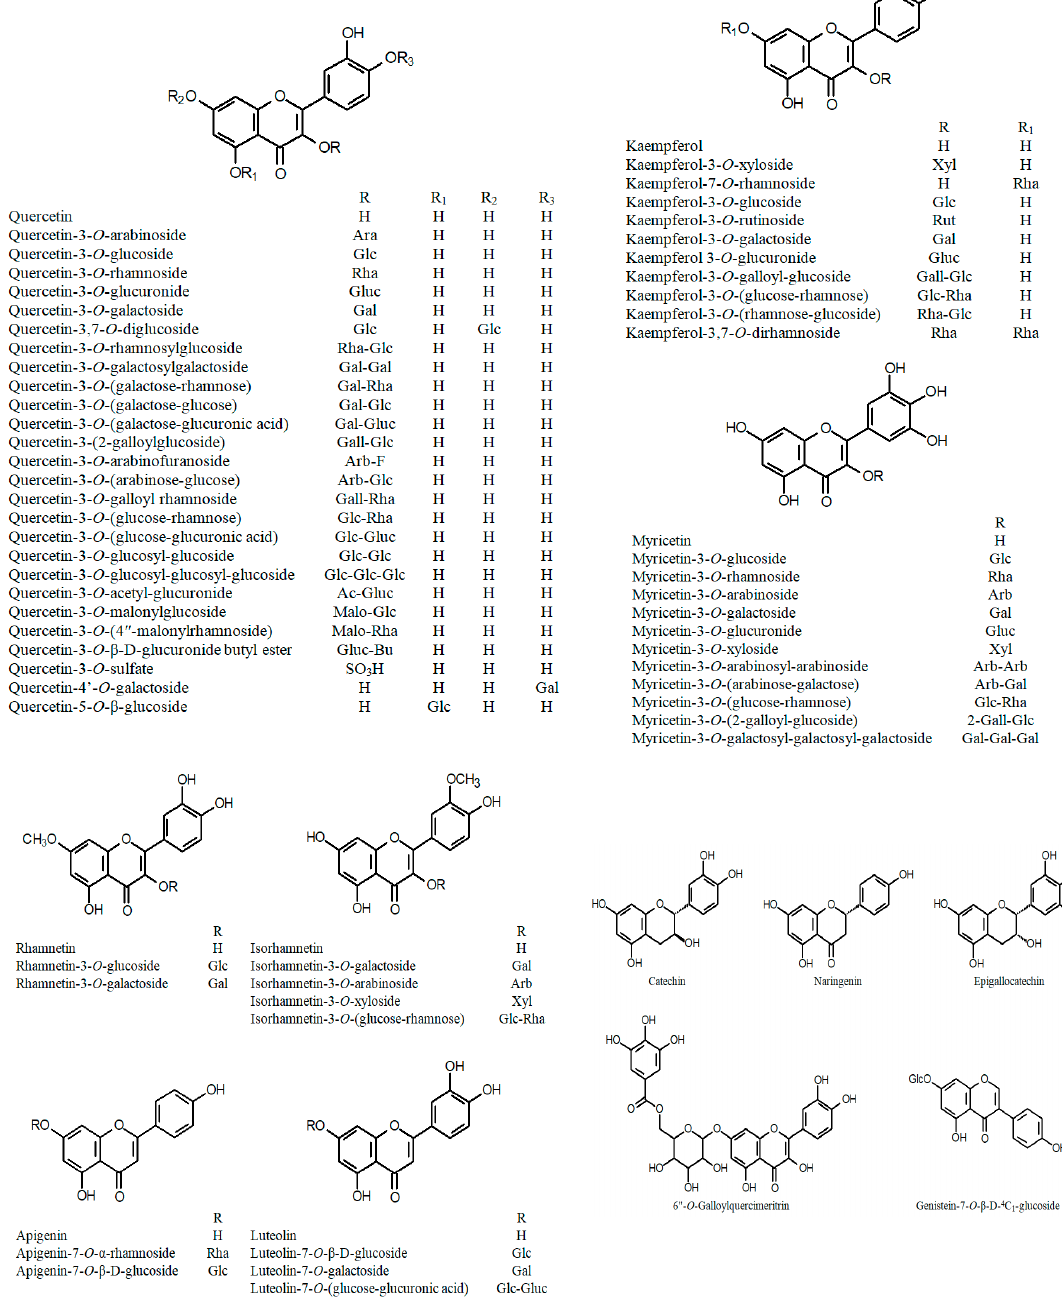
Figure 1. Chemical structures of flavonoids and their derivatives of the genus Cuphea